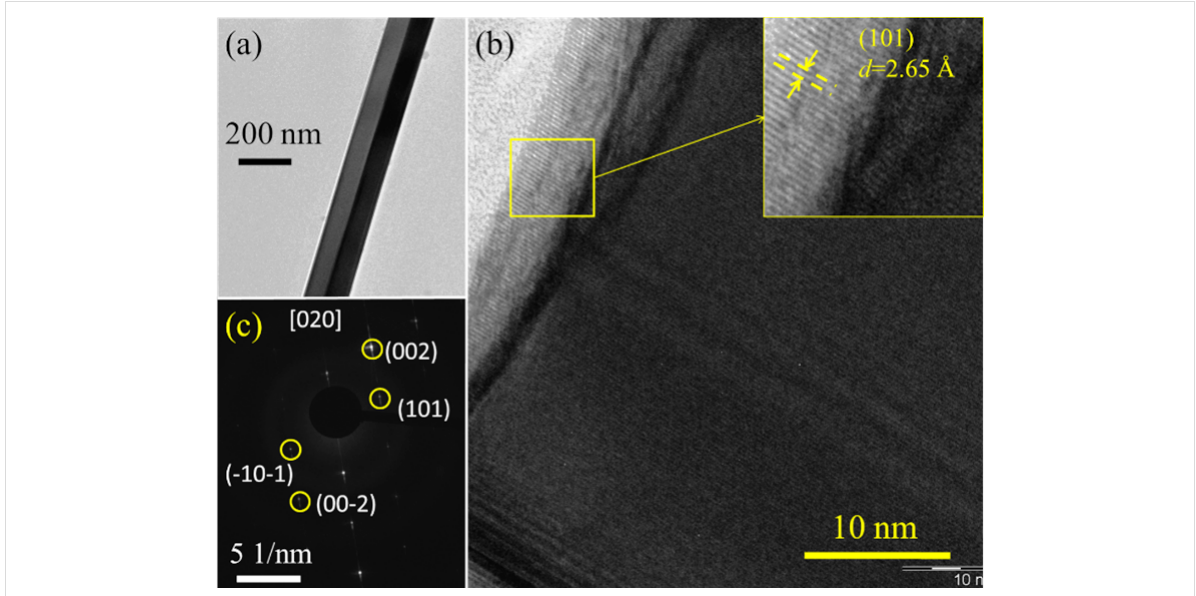
Figure 2: TEM images of square-shaped NWs. (a) Low-magnification image of a single NW. (b) HRTEM image of a NW. Inset shows the (101) plane of rutile SnO 2 . (c) SAED pattern of NWs obtained along the [020] zone axis.